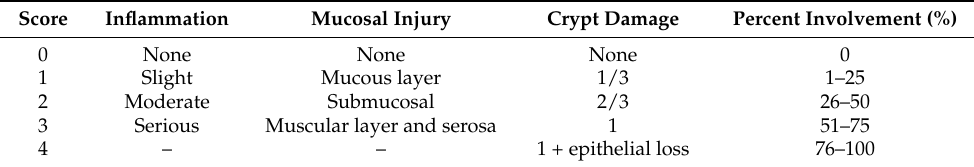
Table 2. Histological scoring